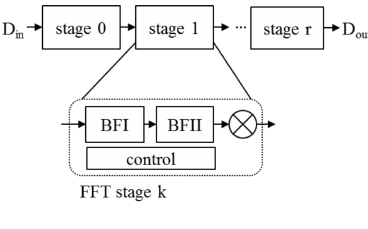
Figure 5. Twiddle factor multiplier implementation.